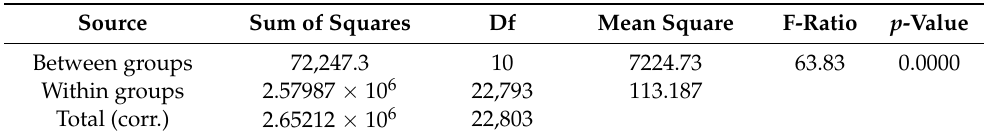
Table 2. ANOVA analysis of the duration of periodical technical inspection (PTI) performed by PTI inspectors.